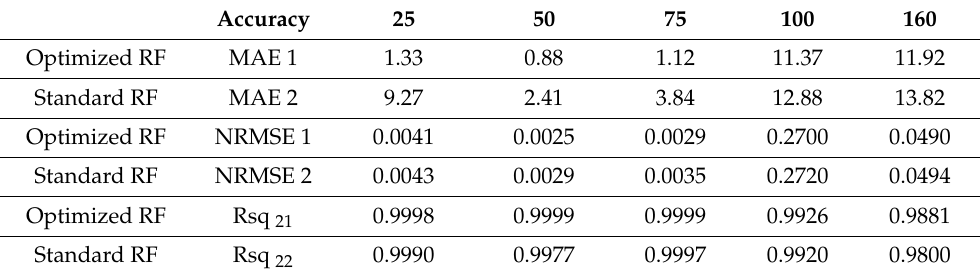
Table 5. Proposed RF-LS-BPT and standard RF regression model accuracy for testing.